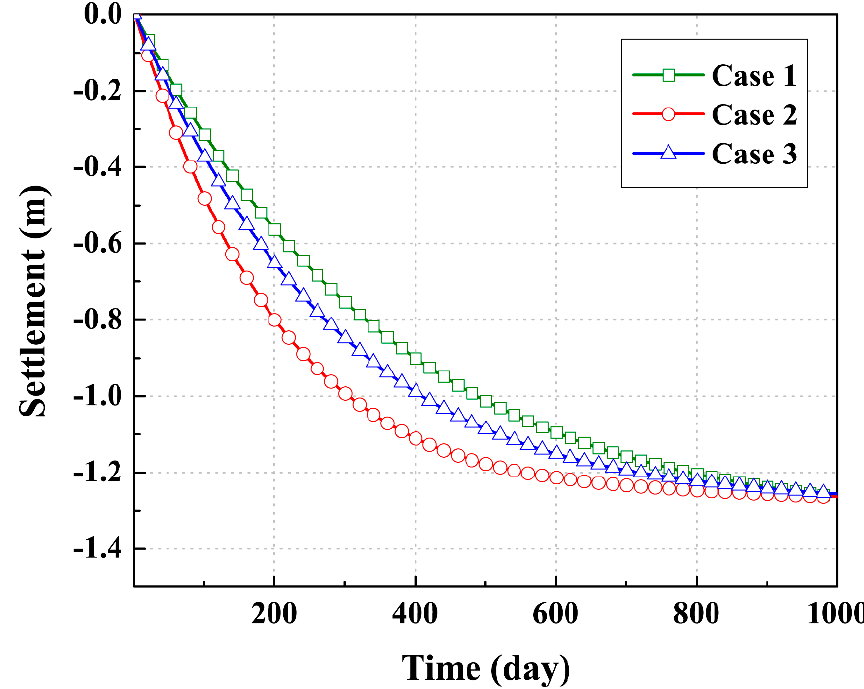
Figure 10. Stabilization process of settlement in landfill.